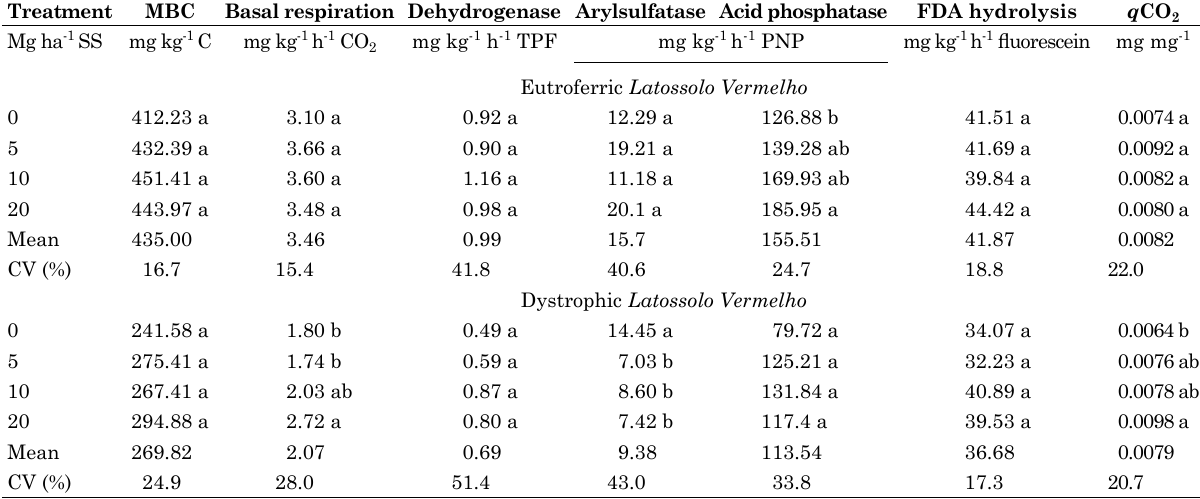
table 6. Biochemical and biological properties in eutroferric and dystrophic Latossolos Vermelhos in the 0-0.20 m layer, treated for 16 years with sewage sludge at different rates treatment mBC